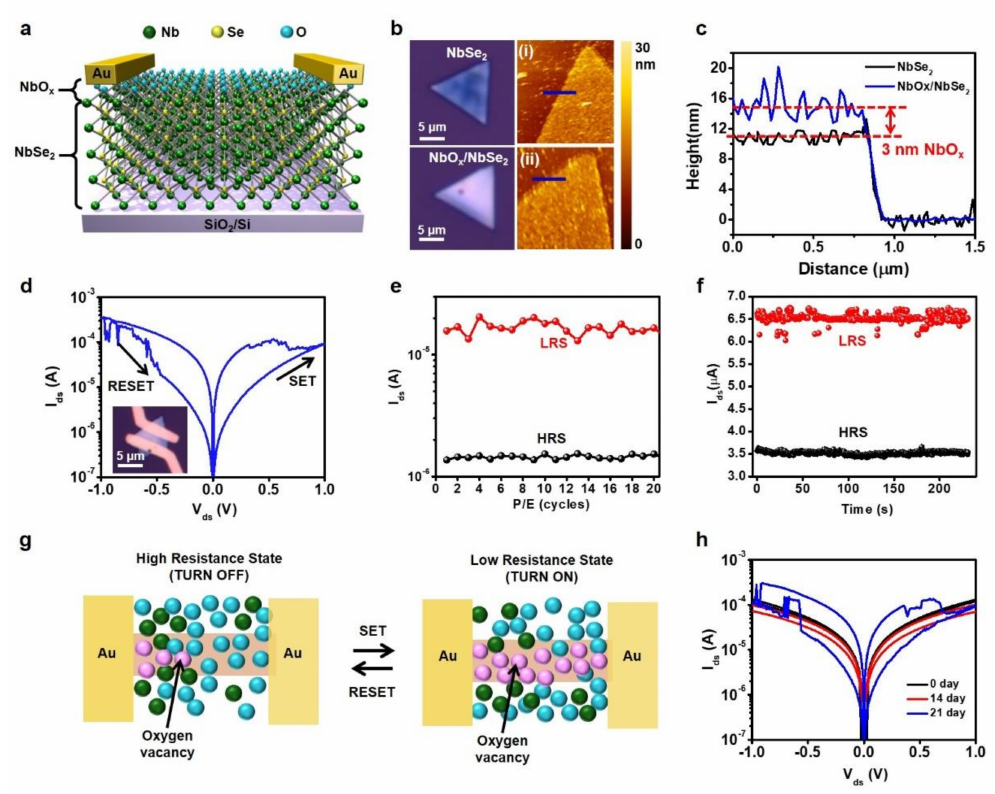
Figure 4. NbO x / NbSe 2 van der Waals memristive memory properties. ( a ) The schematic image of the NbO x / NbSe 2 heterostructure memristor. On top of the multi-layer NbSe 2 , NbO x was formed. ( b ) Optical microscope image and corresponding atomic force microscopy (AFM) mapping images of the intrinsic NbSe 2 flake (top panel) and NbO x -formed NbSe 2 flake (bottom panel). ( c ) The height profile of NbO x / NbSe 2 and NbSe 2 heterostructures. It is increased by about 2 nm compared to intrinsic flakes (12 nm), which can prove the formation of the NbO x . ( d ) Typical current − voltage curves of the memristor. The inset figure is the corresponding memristor device. ( e ) Endurance characteristics against repeated resistance switching cycles under 0.1 V read voltage. ( f ) Retention properties of the memristor under 0.01 V read voltage. Non-volatile properties were observed over 3 min without any resistance switching. ( g ) Schematics of memristive switching mechanism by conductive filament formation and rupture processes via migration of oxygen vacancies. ( h ) Hysteresis variation of the NbO x / NbSe 2 hetero memory device according to the oxidation period of the NbSe 2 flake in the